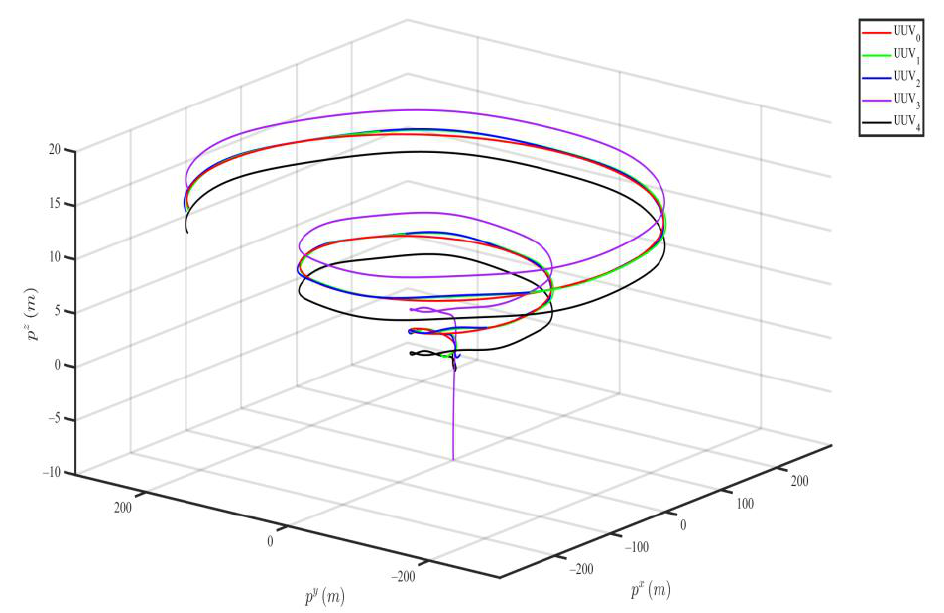
Figure 6. Three-dimensional (3D) trajectory of the UUV formation with collision avoidance under unknown disturbance.